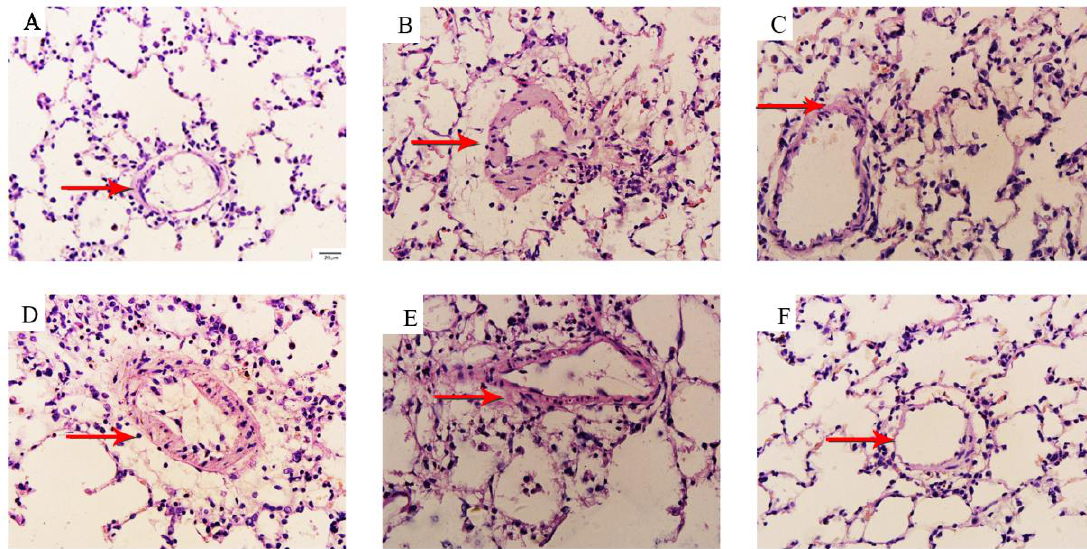
Figure 2. ( A – F ) Effects of betaine on medial wall thickness and small pulmonary arteries assessed by HE staining (magnification × 400). ( A ) Control group, ( B ) MCT group, ( C ) sildenafil group, ( D ) betaine 100 mg/kg group, ( E ) betaine 200 mg/kg group, and ( F ) betaine 400 mg/kg group.